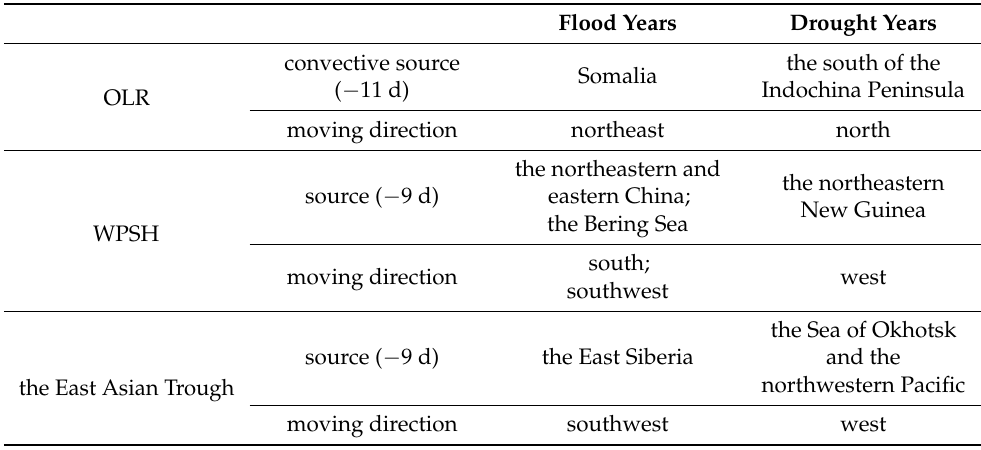
Table 3. The source and moving direction of the predictive signals of the LF key systems that affect the LF precipitation at low and mid-high latitudes in flood and drought